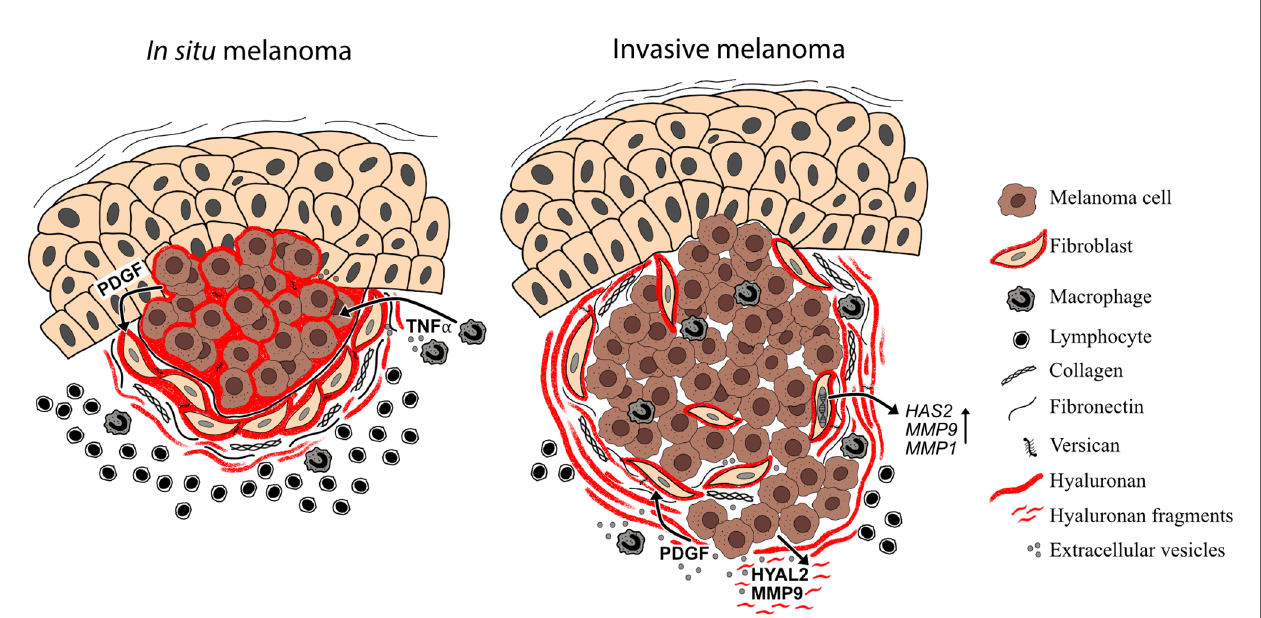
FIGURE 4 | Melanoma-stroma-ECM in super fi cial and deep melanomas. Super fi cial melanomas ( in situ melanoma) have high tumoral hyaluronan content and the stroma contains also abundantly hyaluronan, which is produced by cancer associated fi broblasts. In addition to hyaluronan, melanoma stroma contains other ECM components such as type I collagen, fi bronectin and versican. This hyaluronan-rich pericellular matrix surrounding the melanoma cells may mask the tumor cells from immune cell recognition. In deep melanomas (i.e. invasive melanomas), the tumoral hyaluronan content is decreased but stroma is still hyaluronan positive. The hyaluronan and hyaluronan fragment -rich matrix in the tumor stroma may, in turn, facilitate the invasion and metastasis of melanoma cells. In the TME, soluble growth factors (e.g. PDGF), cytokines (e.g. TNF a ) and extracellular vesicles, produced by both tumor and stromal cells regulate the expression of HAS2, HYAL2 and